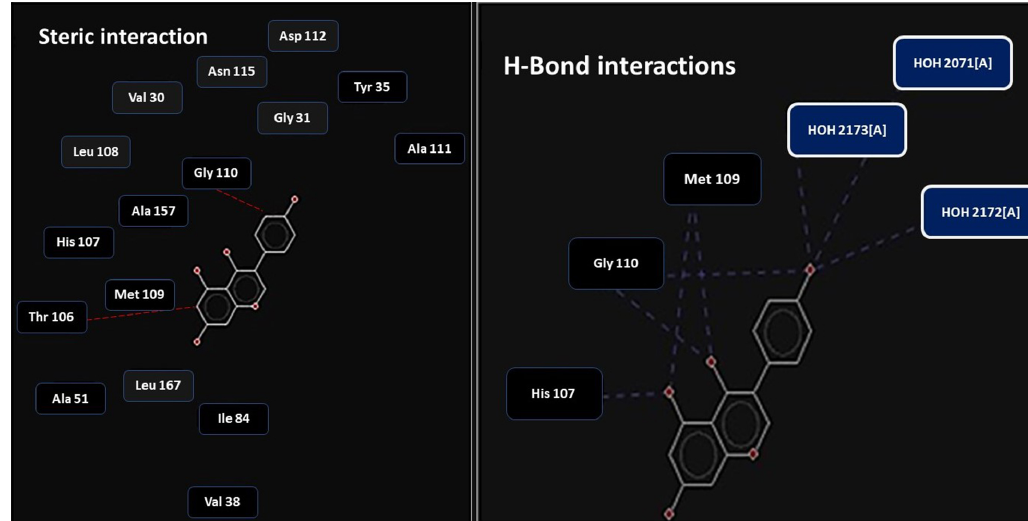
Fig. 10. H-Bond and steric interactions of genistein inserted in the functional site of